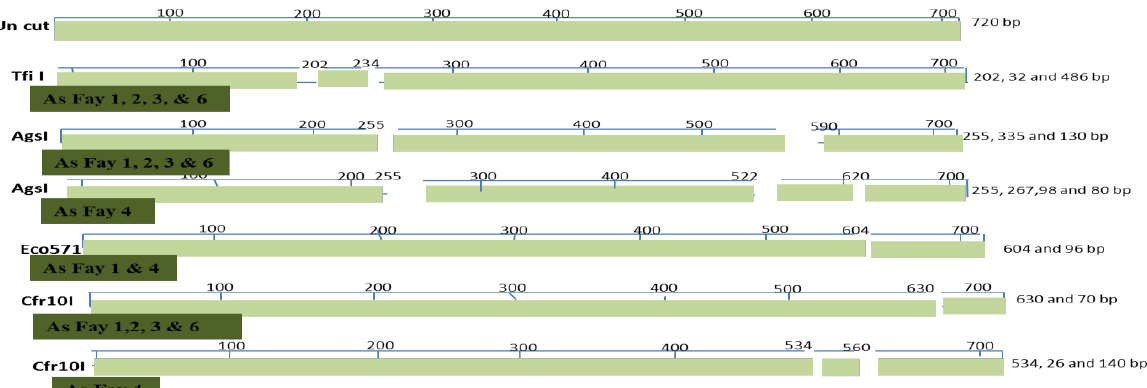
Figure 5. Restriction map of Eco RI , Nco I and Bam HI on the ITS PCR products for Brassica accessions under investigation (Fay1, 2, 3, 4 and 6).